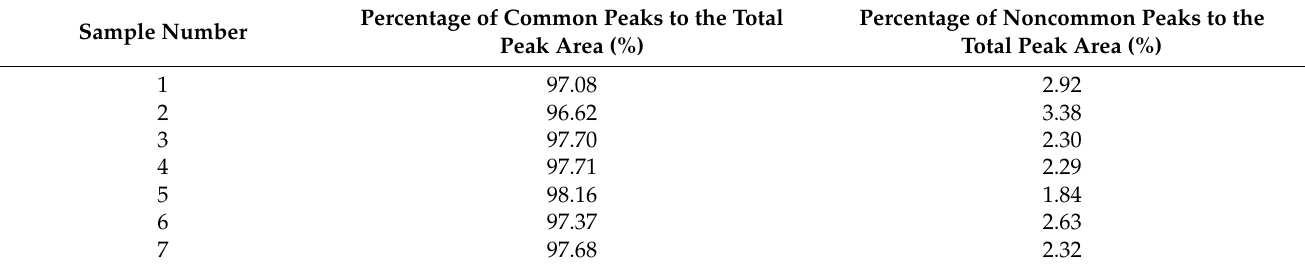
Table 5. Percentage of common peaks and noncommon peaks of the seven batches of S. chamaejasme flowers samples to the total peak